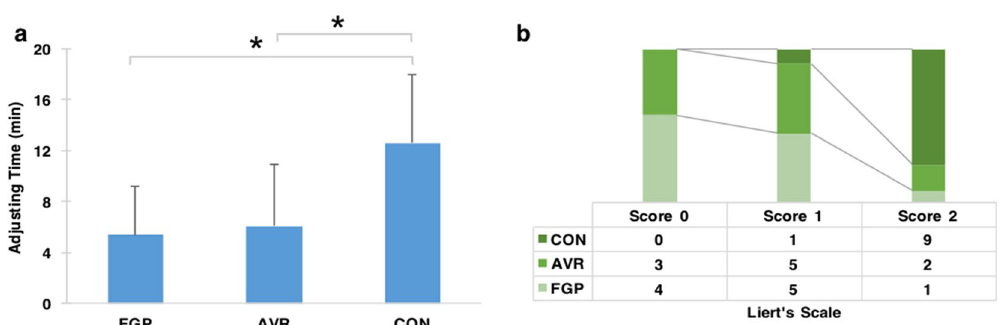
Figure 4. Secondary outcomes of the study. ( a ) Result of time used in adjusting FGP, AVR and CON. FGP and AVR needed less time than CON. ( b ) Result of the distribution difference among FGP, AVR and CON in Likert’s scale. Participants felt better with FGP and AVR crown than